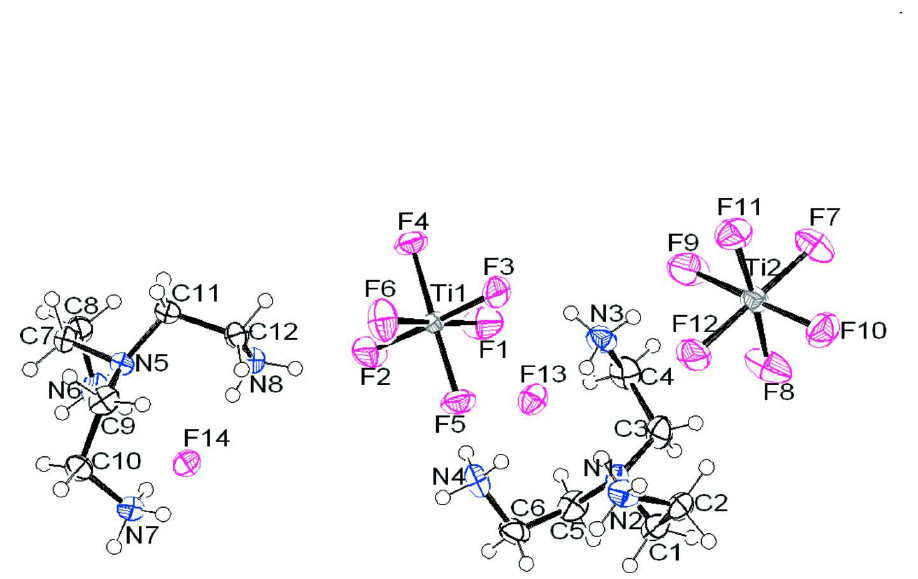
Figure 1 Crystal structure of (I) with displacement ellipsoids for the non-hydrogen atoms drawn at the 50% probability level.